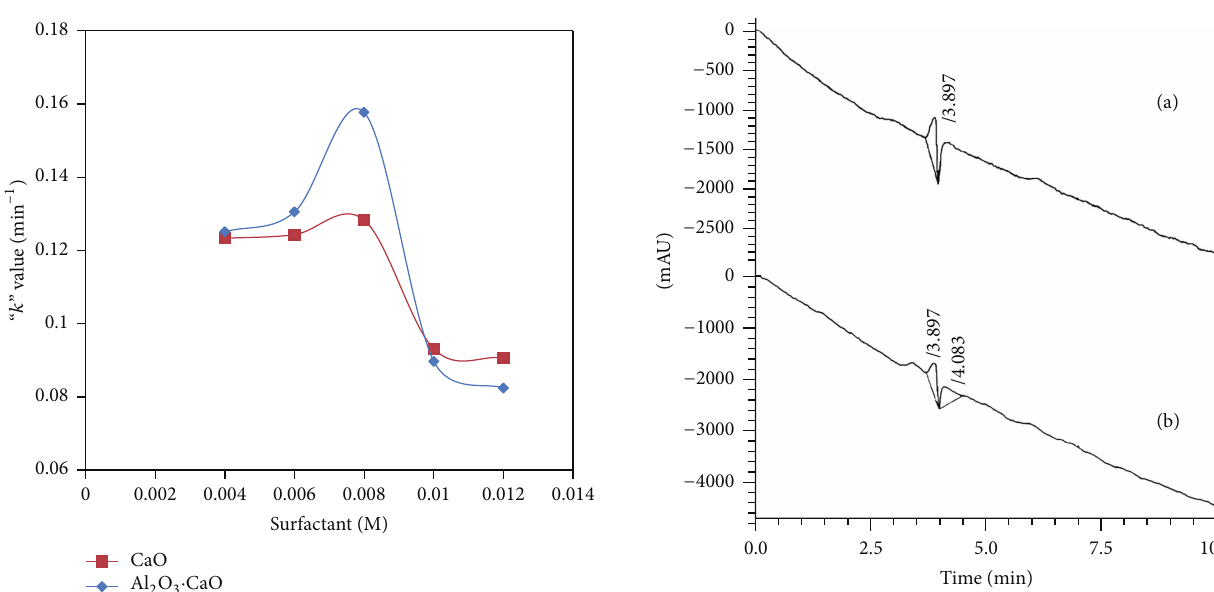
time: 1.625 Base peak: 44.0